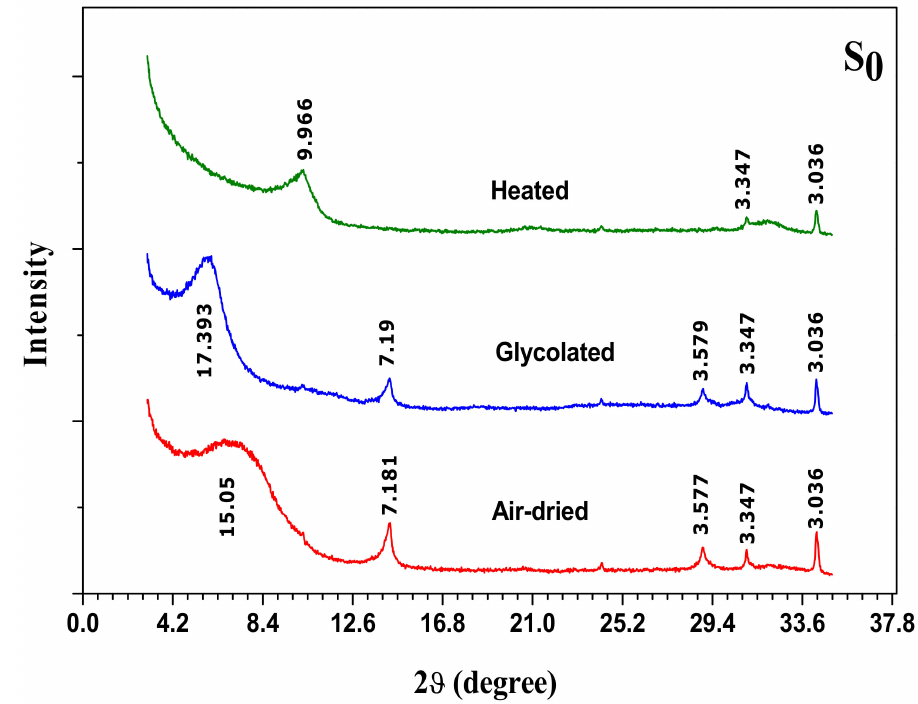
Figure 4. XRDpatternsoforientedaggregatespecimensofrawmaterial( S 0 ): Airdried, glycolatedandheated to 500 ◦ C.